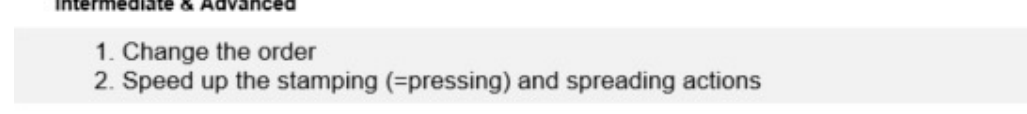
Figure A24. Detailed description and components of each movement in the “Finger stamp” finger-and-toe exercise.